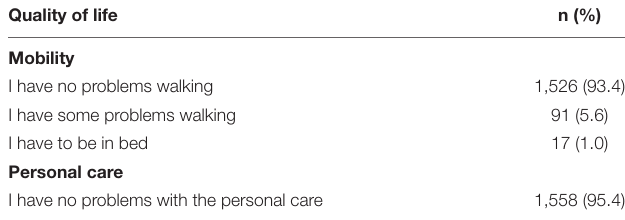
TABLE 2 | Quality of life in Peruvian university students during the COVID-19 pandemic. Quality of life